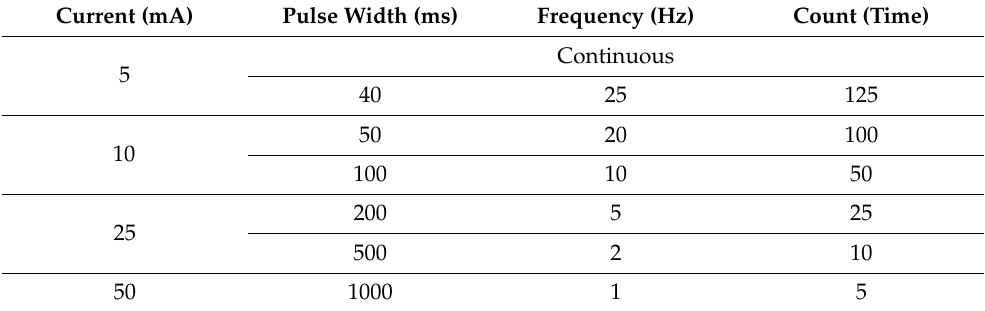
Figure 5. Wave diagrams of ( a ) different stimulation currents, ( b ) direct-current (DC) pulse stimula- tion, and ( c ) alternating-current (AC) pulse stimulation with different pulse widths. Table 1. Stimulation current, pulse width, and stimulation count in the conducted